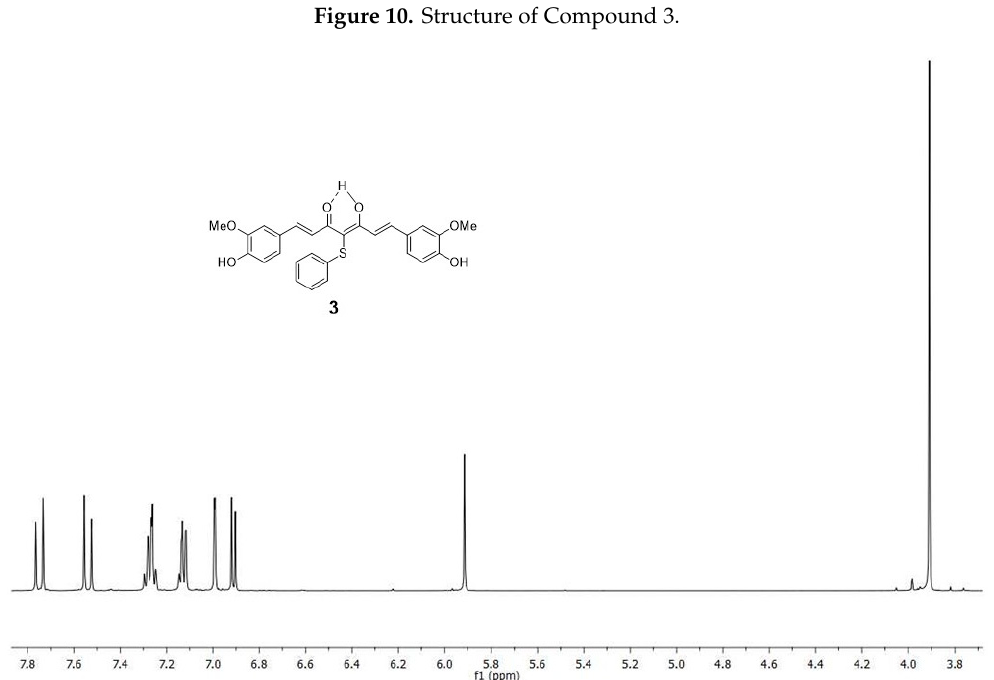
Figure 11. 1 H NMR spectrum of Compound 3 in CDCl 3 as solvent.